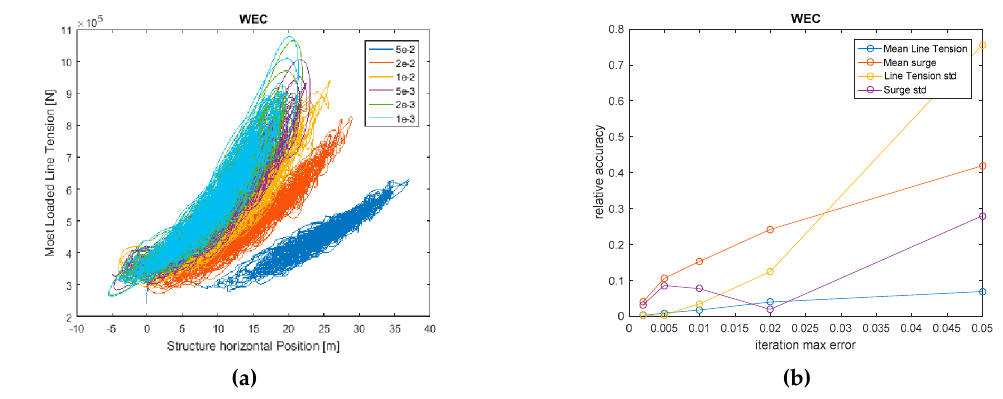
Figure 2. Sensitivity analysis of the QSTD model to the iterative process of the catenary equations. Surge of the structure and the corresponding mooring horizontal force ( a ) and relative errors of the standard deviation with di ff erent relative errors allowed in the catenary equations of both line tension and surge motion ( b ).